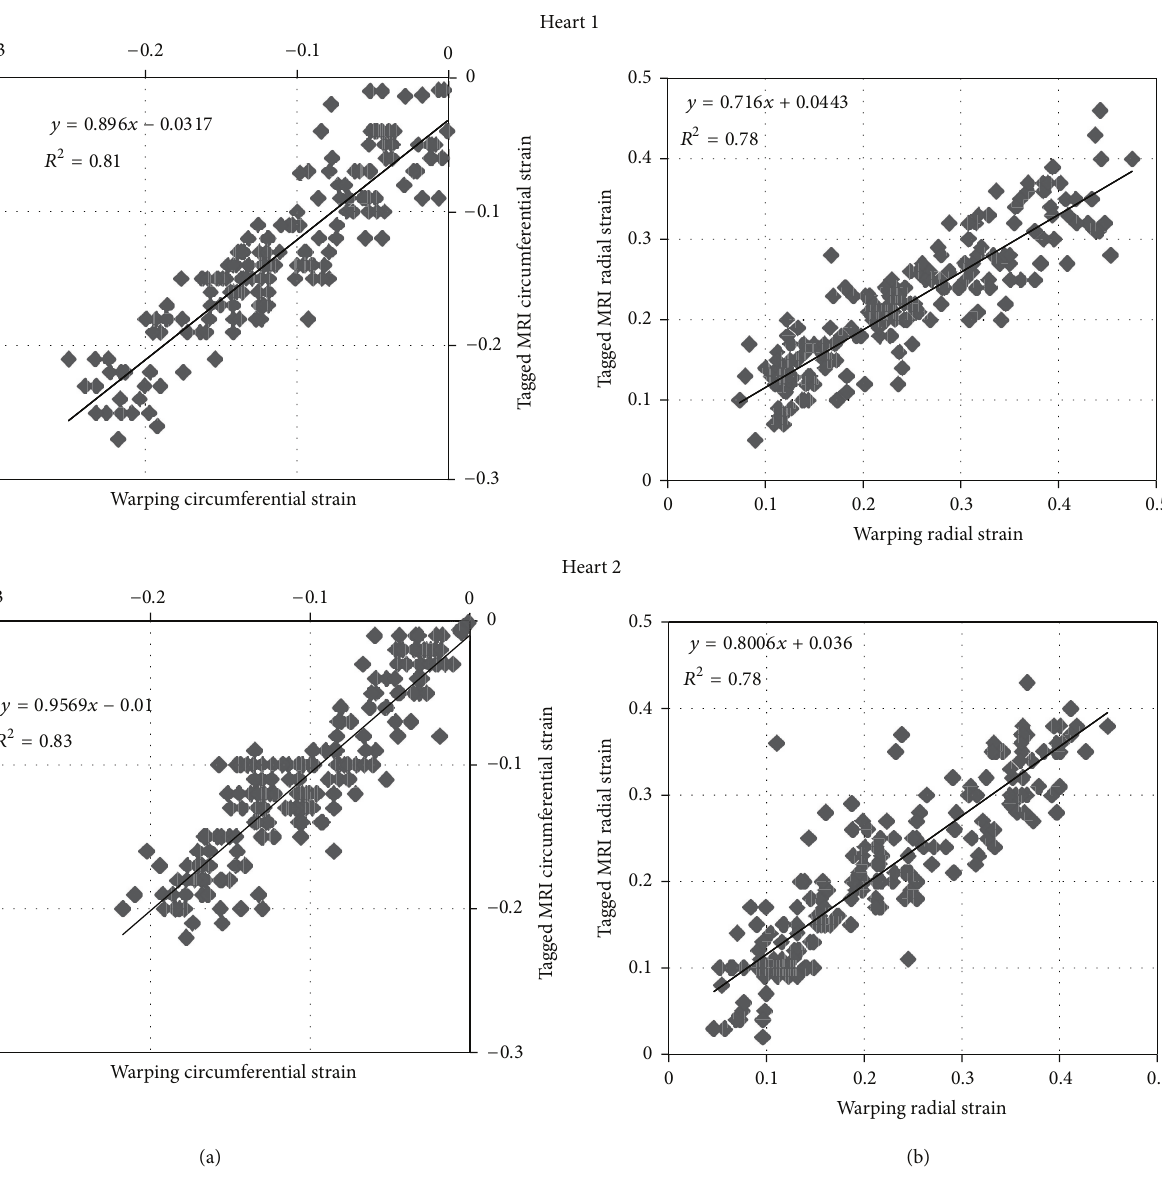
Figure 6: The comparisons of strains for tagged MRI analysis and the warping analysis show relatively good agreement with the comparisons of the circumferential strains (a) having 𝑅 2 values of 0.81 for Heart 1 and 0.83 for Heart 2. The comparisons of the radial strains (b) had 𝑅 2 values of 0.78 for both